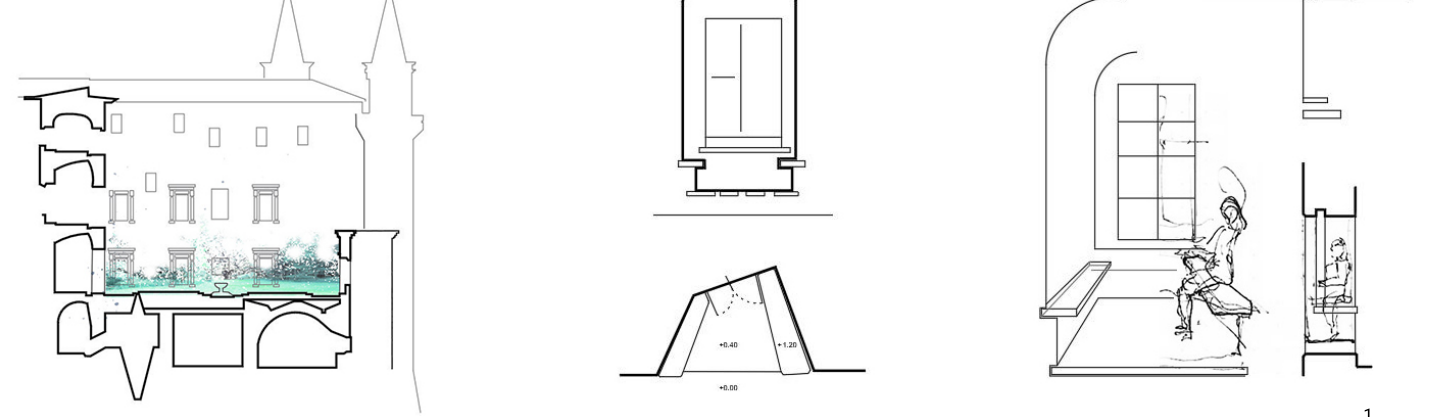
Section through “ Giardino Pensile ” and its empty and full wall in the Palazzo Ducale of Urbino. Source: Drawing by the author from a visit to